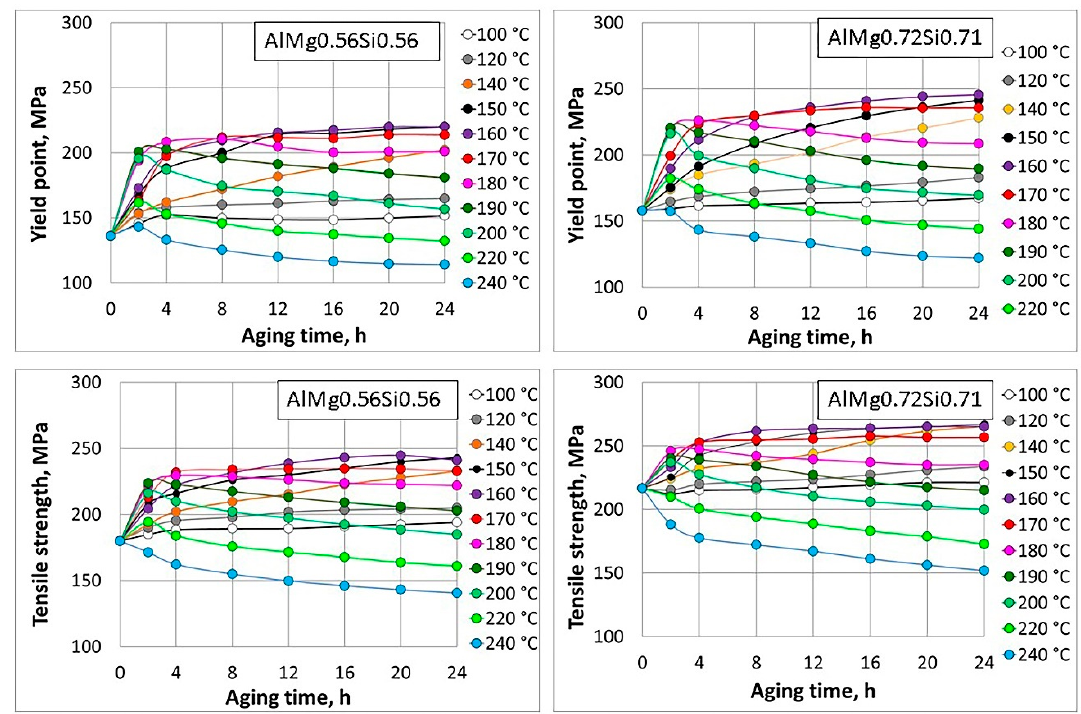
Figure 7. Relationship between strength and artificial aging time at different temperatures for the AlMg0.56Si0.56 and AlMg0.72Si0.71 wire rods.